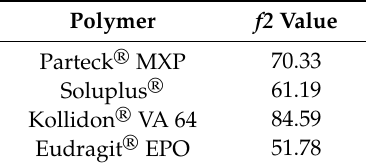
Table 6. Similarity factor ( f2 ) for the VCM 20 mm samples and HME